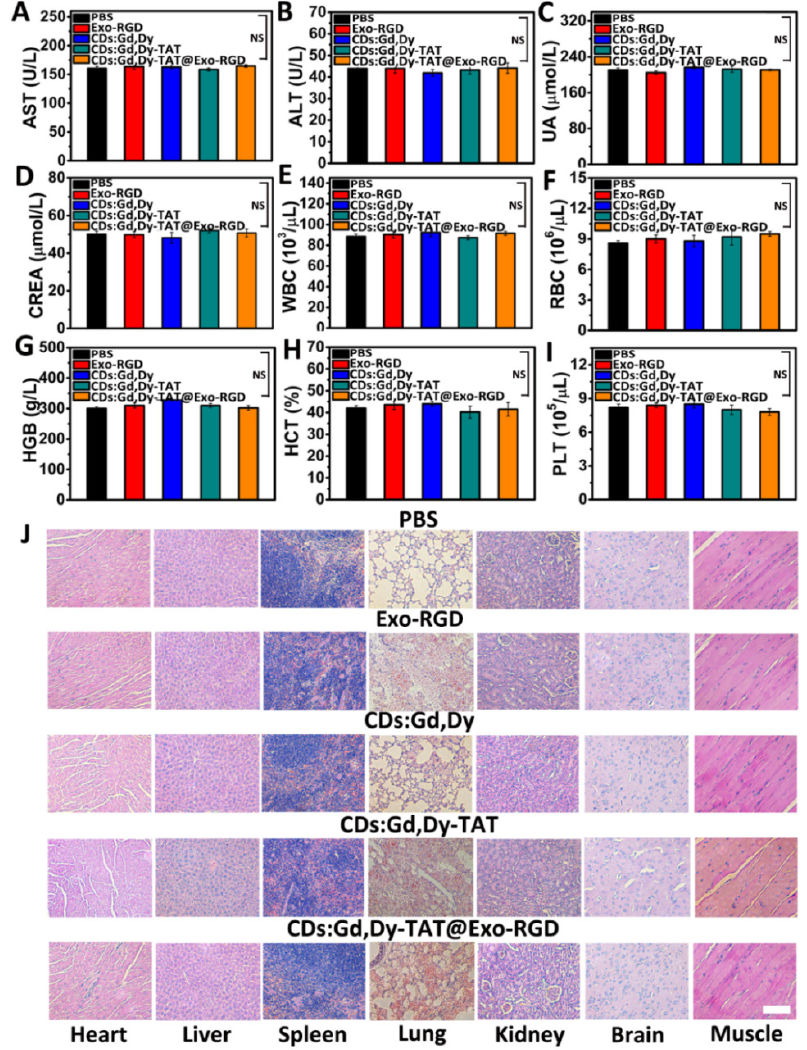
Figure 7. In vivo biocompatibility assessment. ( A – D ) Serum biochemical markers of ALT, AST, UA, and CREA and ( E – I ) whole blood cell analysis of the mice treated with PBS, Exo-RGD, CDs:Gd,Dy, CDs:Gd,Dy-TAT or CDs:Gd,Dy-TAT@Exo-RGD two weeks following administration, NS, p > 0.05. ( J ) H&E images of major organs (heart, liver, spleen, lung, and kidney), brain and muscle from different treatment mice, scale bar: 100 µ